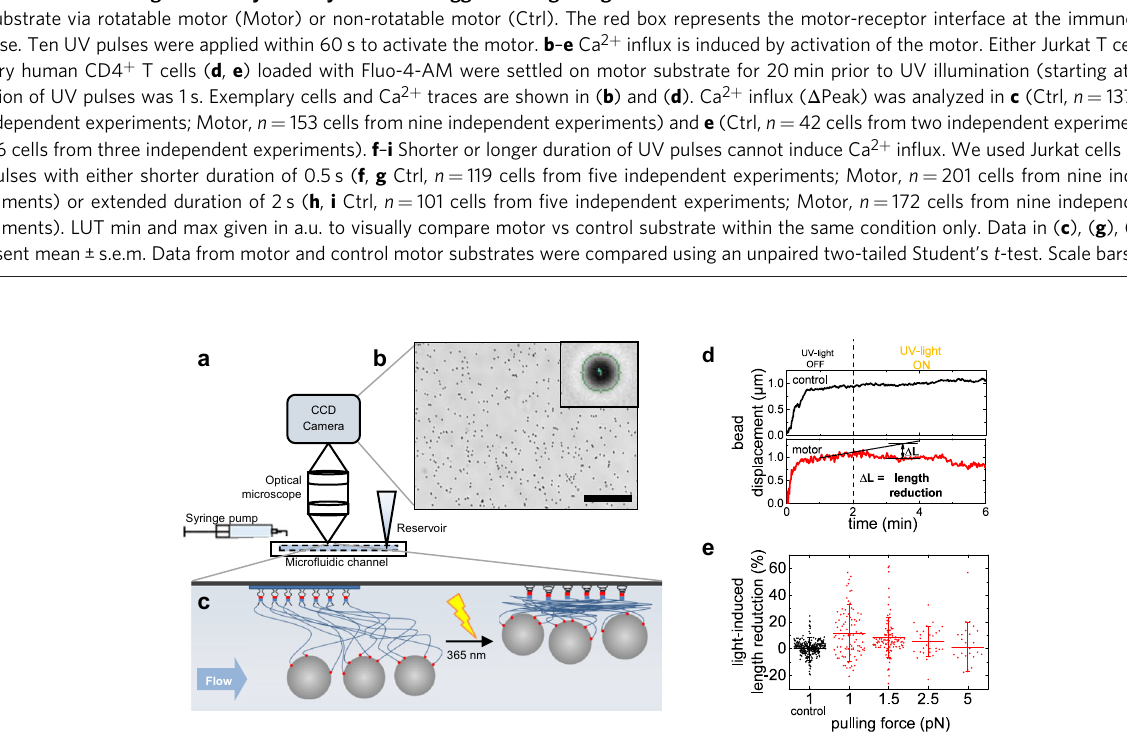
Fig. 3 Measurement of forces applied by the light-driven rotary motor. a Experimental setup for the observation of tethered particle motion in a micro fl uidic fl ow channel. b Optical microscopy determines the movement of hundreds of surface-tethered beads in parallel (scale bar: 100 µ m); the inset demonstrates tracking of one exemplary 500-nm bead. c Sketch of the molecular arrangement under fl ow before and after UV-light irradiation. Micro- beads are attached to the motor molecules via multiple DNA chains. Upon light activation, the molecular motor twists the entangled DNA chains and the construct pulls the beads in. d Typical bead displacement versus time after start of fl ow with a drag force of 1 pN. The bead displacement is suddenly reduced after the molecular motor is activated by UV light. No such reduction is observed in control experiments with the static motor molecule. e Average light-induced length reduction of n beads (mean ± standard deviation) after 2 min of UV-light irradiation for rotary motor molecule against different fl ow- induced drag forces and for the control with static molecules for 1 pN, normalized to the expected length of the construct ( n = 307 (control), n = 97 (1 pN), n = 106 (1.5 pN), n = 28 (2.5 pN), and n = 26 (5 pN) obtained in fi ve independent